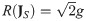
Dynamical regimes of a N-dimensional network model with random Gaussian connectivity structure.Each entry of J is independently drawn from a Gaussian distribution with zero mean and variance g2/N. A. The eigenvalues of J are complex, and, in the limit of large N, distributed uniformly within a circle of radius R(J) = g in the complex plane (Girko’s law, [41]). The system is stable if g < 1. Left: g = 0.5. Right: g = 0.9. B. The eigenvalues of the symmetric part JS are real-valued, and are distributed in the large N limit according to the semicircle law, with the largest eigenvalue of JS given by the spectral radius R(JS)=2g [42, 43]. Since the spectral radius of JS is larger than the spectral radius of J, for sufficiently large values of g some eigenvalues of JS can be larger than unity (in red), while the network dynamics are stable (g < 1). C. Spectral radii of J and JS as a function of the random strength g. The interval of values of g for which the system displays strong transient dynamics in response to specific inputs is given by 1/2<g<1. N = 200 in simulations.